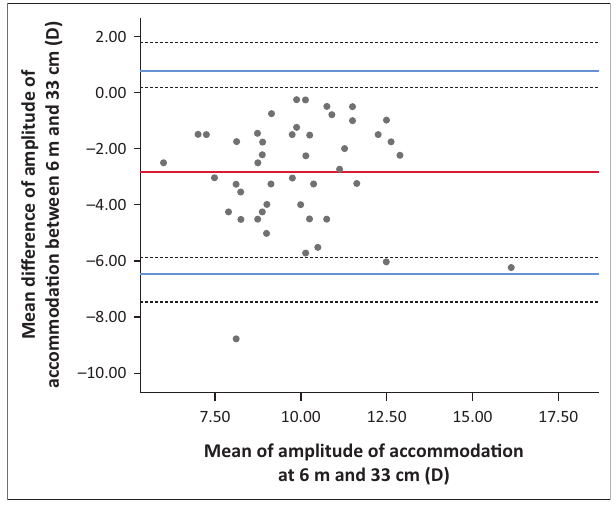
FIGURE 5: Bland–Altman plot showing the difference between the amplitude of accommodation at six metres and 40 cm. The bold red line represents the mean difference or bias. The blue solid lines indicate the upper and lower 95 % LoA (bias ±1.96 [s.d.]) while the black dotted lines represent the 95 % confidence interval of the upper and lower limits of agreement. LoA, limits of agreement.